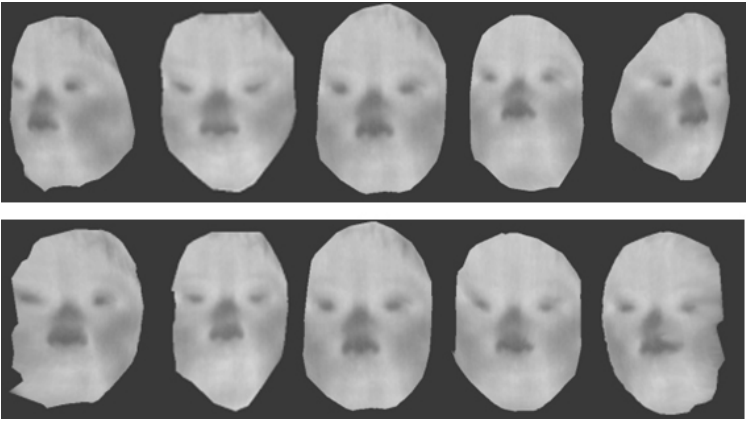
Figure 18. The first row shows 3D thermal-IR multi-spectrum face data before normalization, and the second row shows normalized 3D thermal-IR multi-spectrum face data.